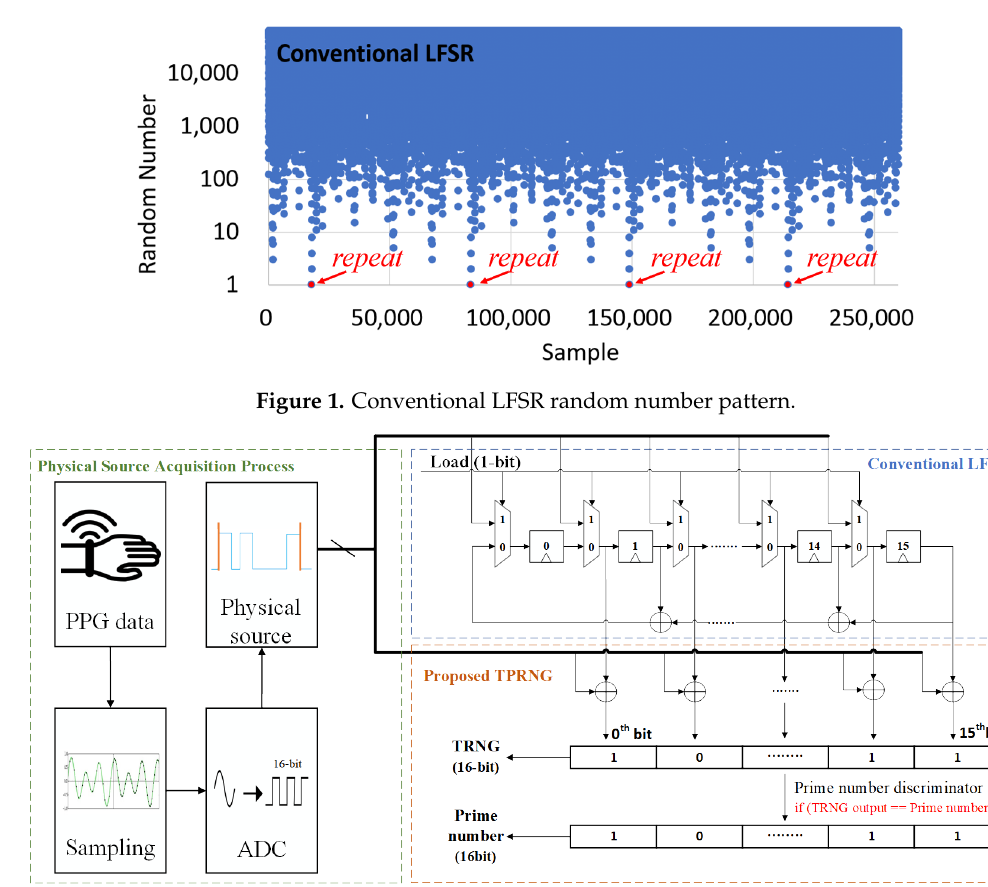
Figure 2. Proposed true prime number generator block